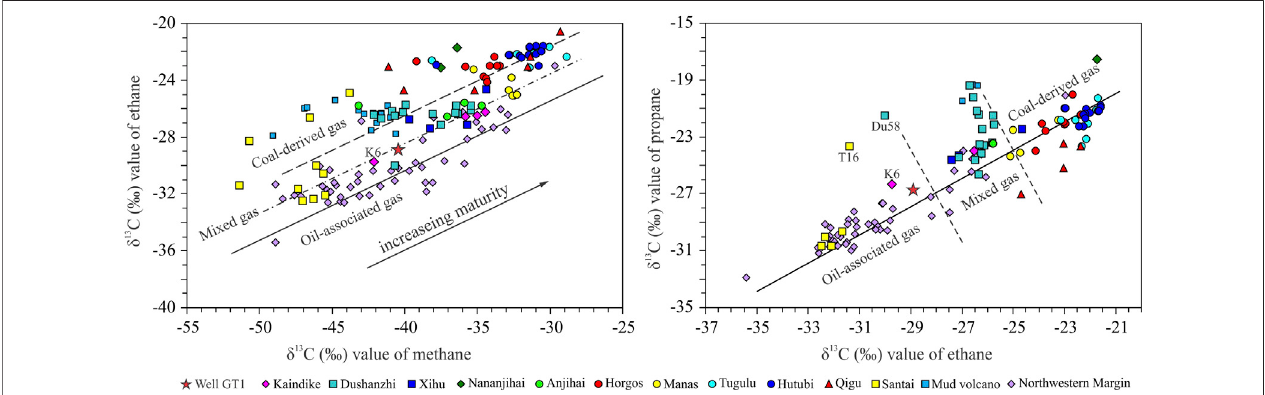
FIGURE 5 | Carbon isotopic composition and types of natural gas in southern margin (Modi fi ed from Chen et al., 2019. The data regarding mud volcano are cited from Dai et al., 2012, and the data for the Northwestern margin is provided by the Research Institute of Xinjiang Oil fi eld Company).